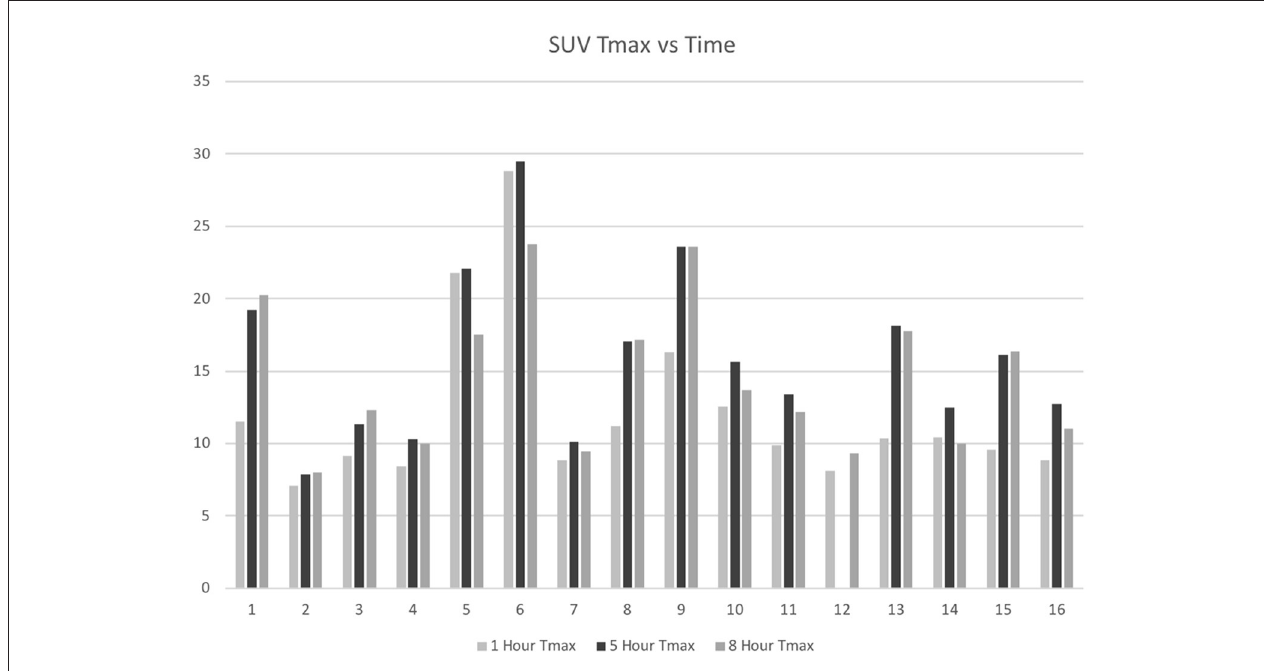
FIGURE 1 | IDH-mutant, glioblastoma F18-FDG tumor maximum SUV at 1-, 5-, and 8-h following F18-FDG injection.